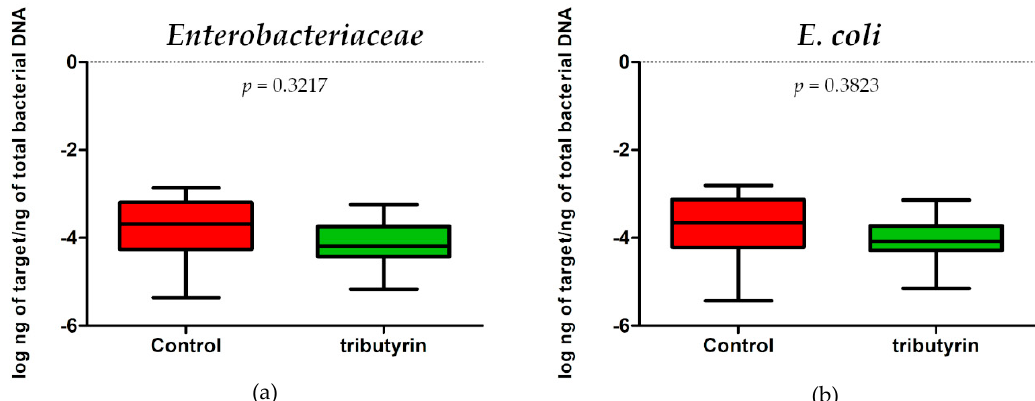
8 of 16 Figure 2. Hair cortisol concentrations (pg/mg) in the control group (CTRL) and in the group of piglets fed a diet supplemented with 0.2% tributyrin (TRIB). Data are presented as the mean ± SE. a,b: significant differences between groups ( p = 0.018). 3.6. DNA Extraction and Real ‐ Time PCR to Determine Gut Microbiota